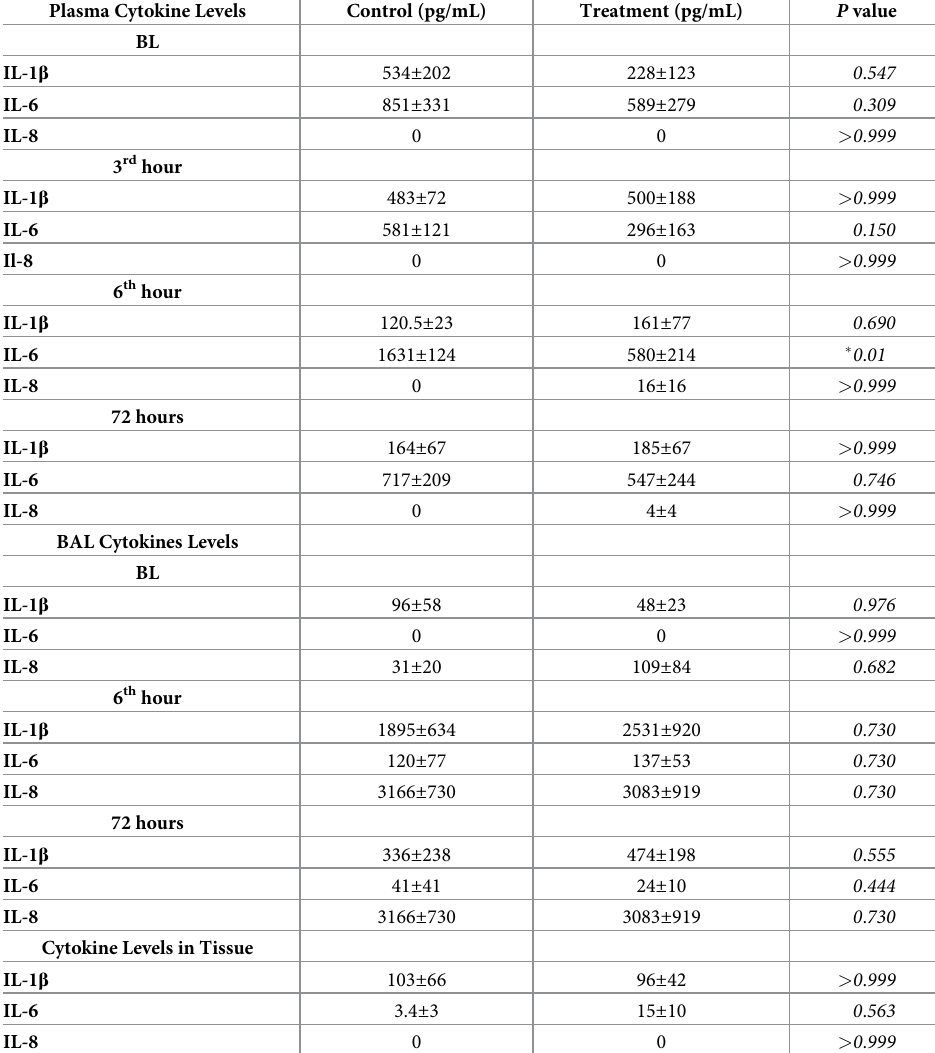
Table 1. Cytokine levels in plasma, bronchoalveolar lavage and lung tissue at baseline, 3, 6, and 72 hours. Plasma Cytokine Levels Control